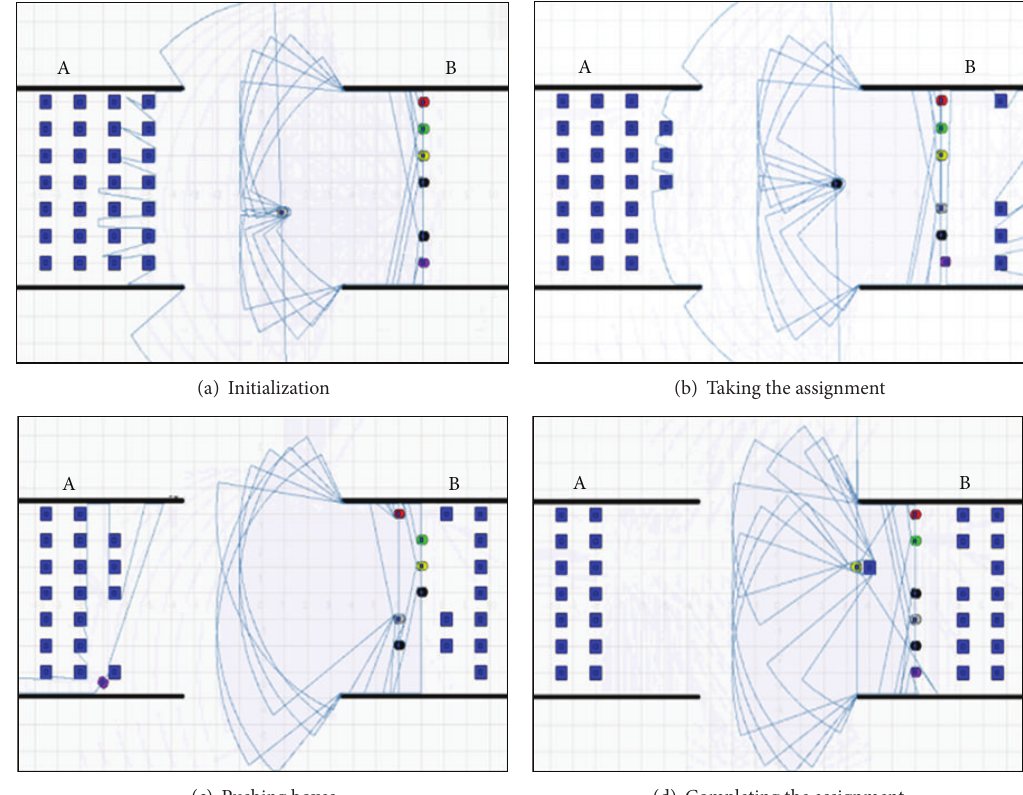
Figure 6: Simulation of auction allocation.